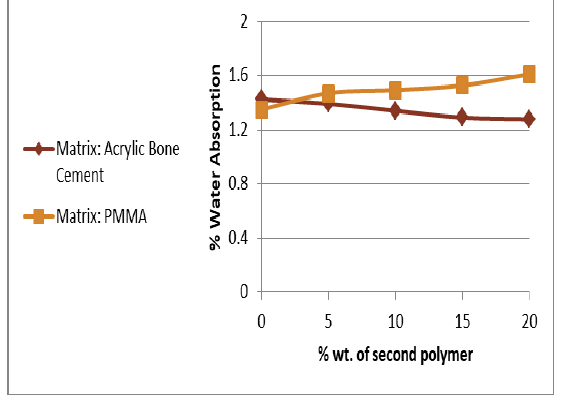
Figure, 5: Water absorption of (Acrylic bone cement: % X PMMA), and (PMMA: %